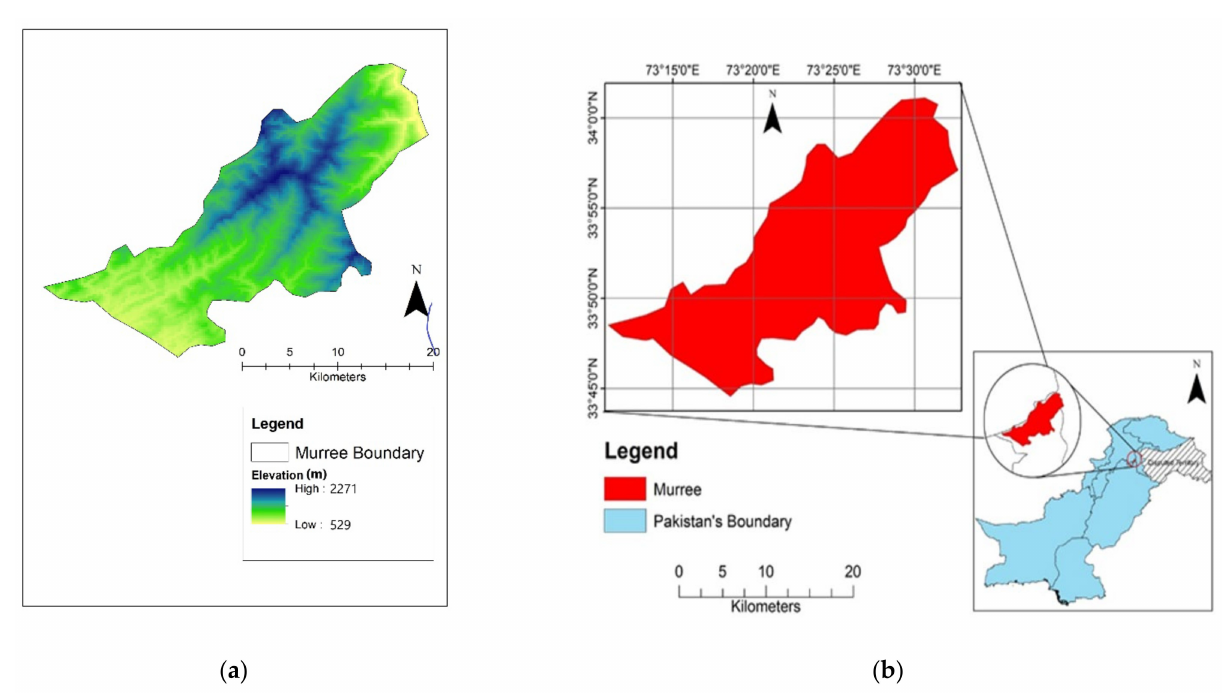
Figure 1. ( a ) Digital elevation model of the study area ( b ) Map showing the location of the study area in